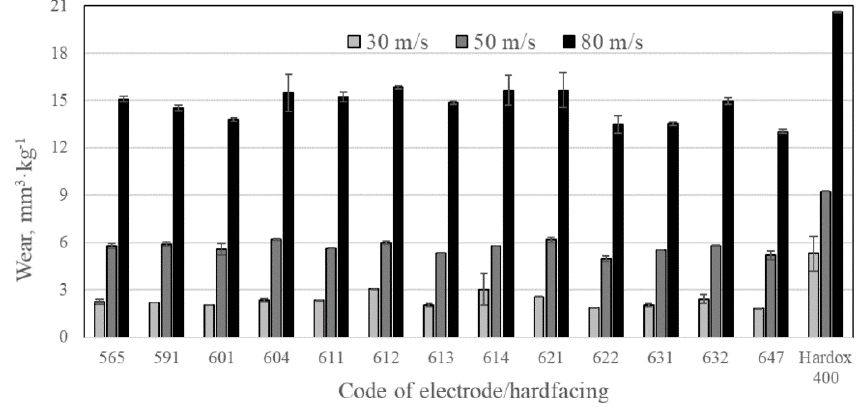
Figure 8. Wear rates of Fe–C–Cr hardfacings during the erosive tests at the speeds of 30, 50, and 80 m·s −1